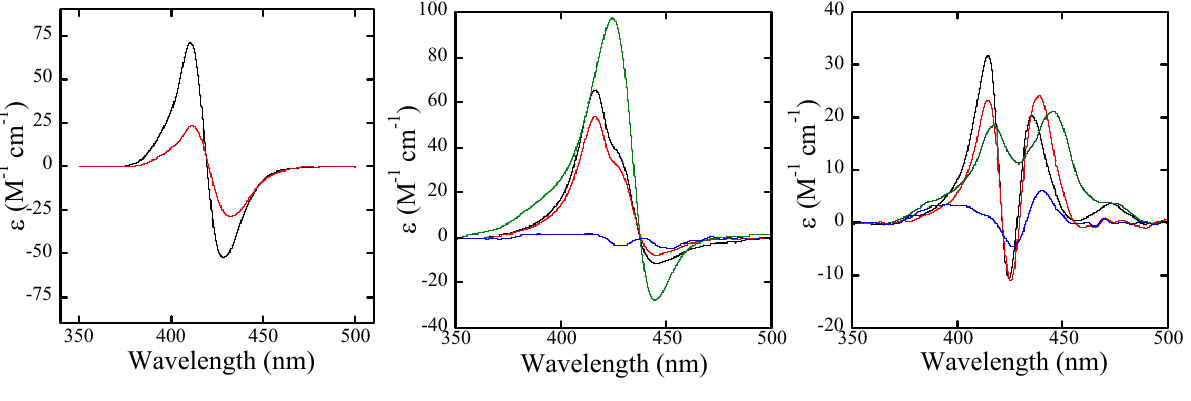
Figure 4. ( a , left) iCD spectra of H pXy (black) and H mXy (red) at their Soret bands in 2 2 the presence of CTDNA at R = 0.01, ( b , center) iCD spectra of ZnpXy in the presence of CTDNA without distamycin (black) and with distamycin (red, [distamycin] / [base pairs] = 0.6), poly(dA)·poly(dT) (green), and poly(dG)·poly(dC) (blue) at R = 0.01, ( c , right) iCD spectra of ZnpXy in the presence of CTDNA without distamycin (black) and with distamycin (red, [distamycin] / [base pairs] = 0.6), poly(dA)·poly(dT) (green), and poly(dG)·poly(dC) (blue) at R =